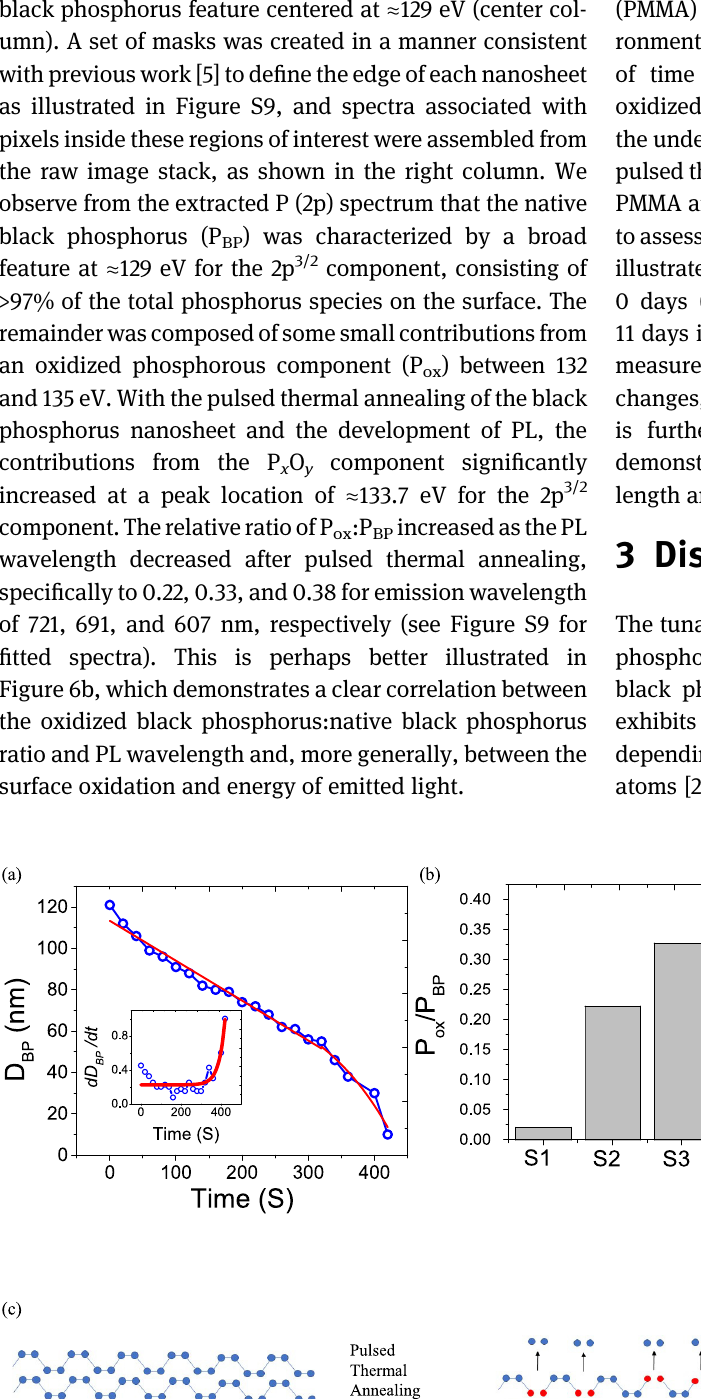
Figure 6: (a) Atomic force microscopy (AFM) measurements after each pulsed thermal annealing cycle for a nanosheet with an initial thickness of 120 nm. The inset shows dD BP / dt versus annealing time with an exponentialdecreaseforthelastfewcycles. (b) The ratio of black phosphorus oxide to black phosphorus measured using